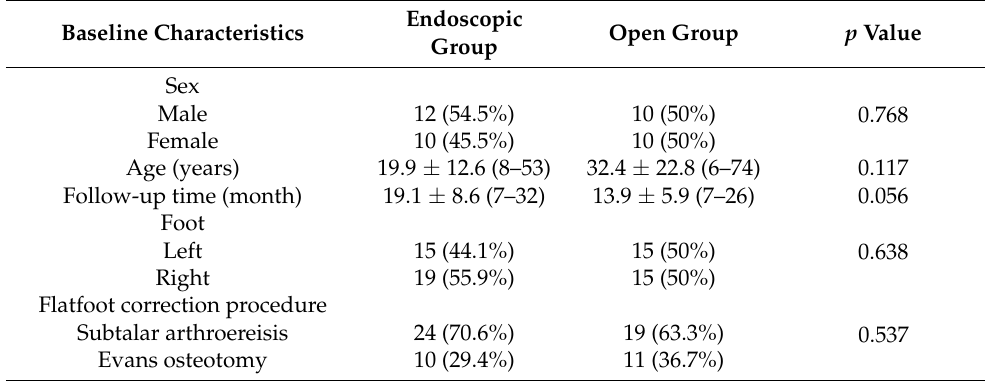
Table 1. Baseline characteristics of the two